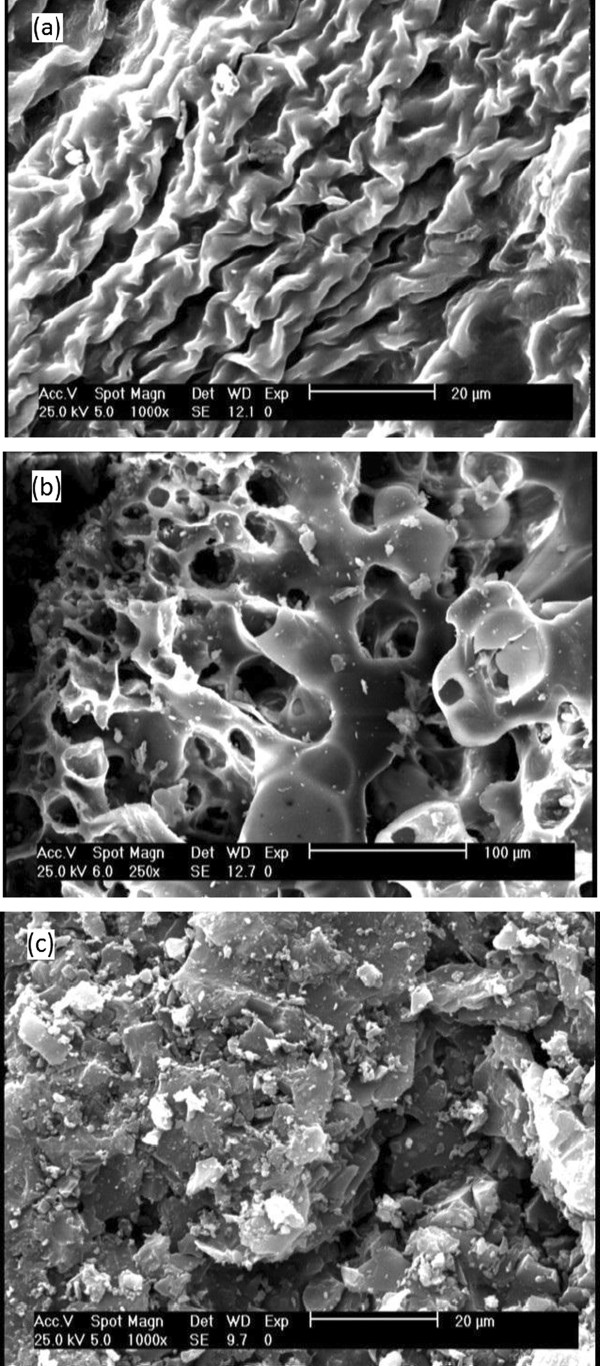
SEM images of (a)
C. indica
biomass (1000×), (b) RBA (250×) and (c) GAC (1000×).